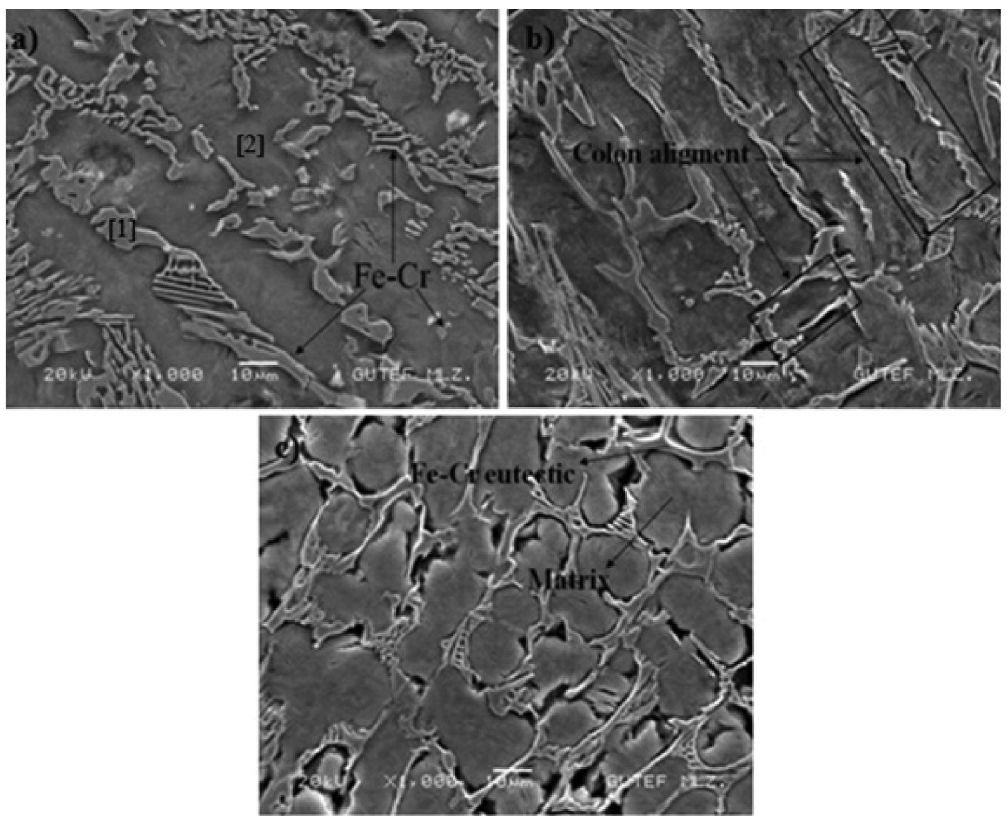
Fig. 3: SEM images of valve seat inserts with three different chemical compositions, (a) 10% Cr, (b) 12% Cr, and (c) 14%.